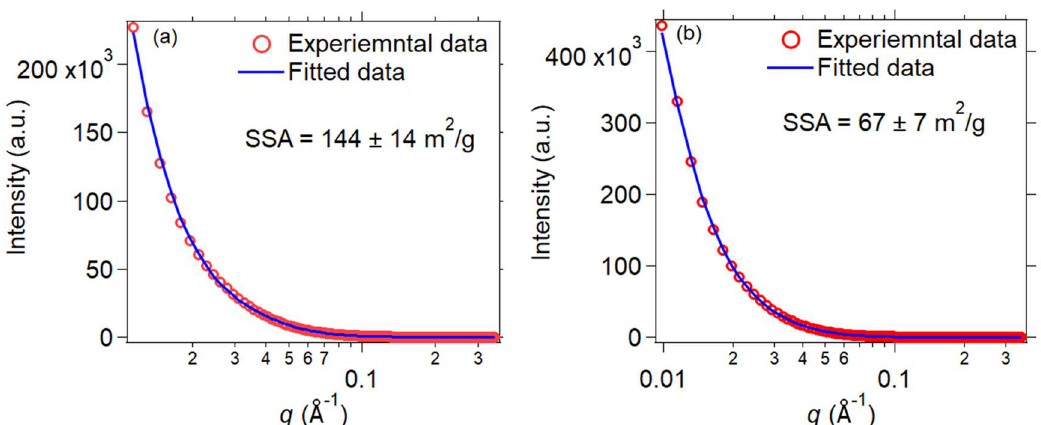
Figure 4. SAXS patterns of the MnB−I ( a ) and MnB−II ( b ) nanoflakes. The red circles are the experimental data, and the solid blue line is the fitted data using a unified fit in Irena. B was 0.07 and 0.03 cm − 1 Å − 4 for MnB−I and MnB−II, respectively. δ was 2.57 g/cm 3 and Δ ρ 2 was 396∙10 20 cm −4 .